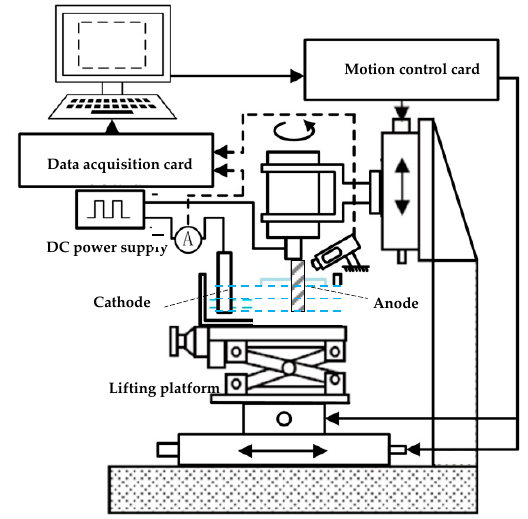
Figure 1. Structure of machine tool.